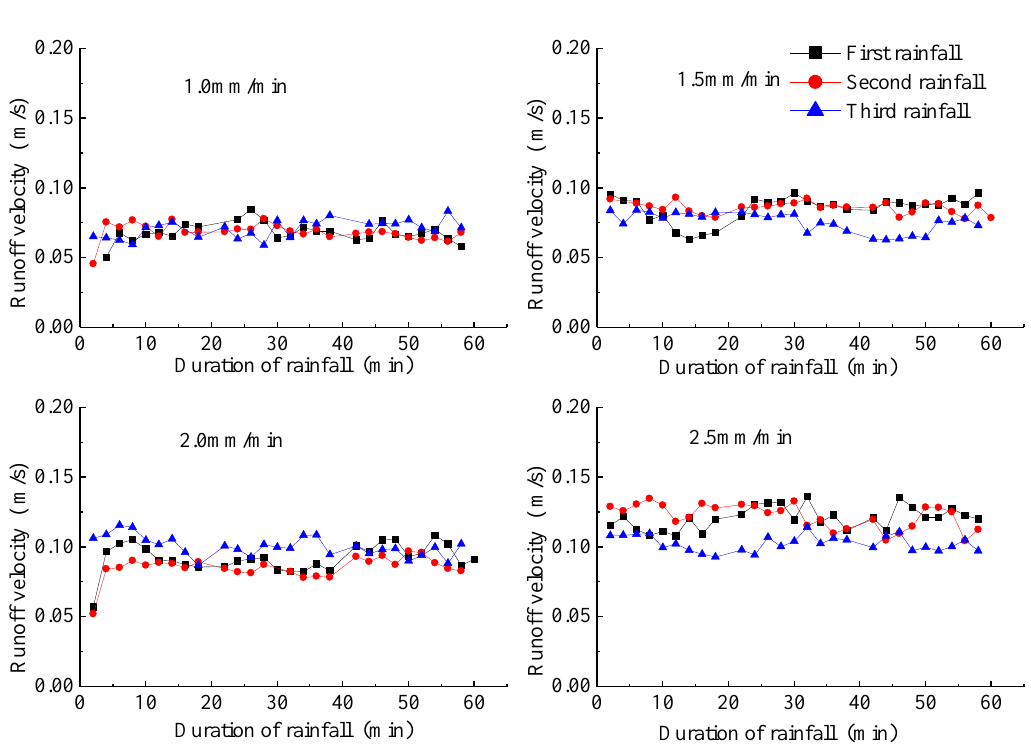
Figure 14. Variation curve of runoff velocity with time of the loess slope at different rainfall densi- ties.